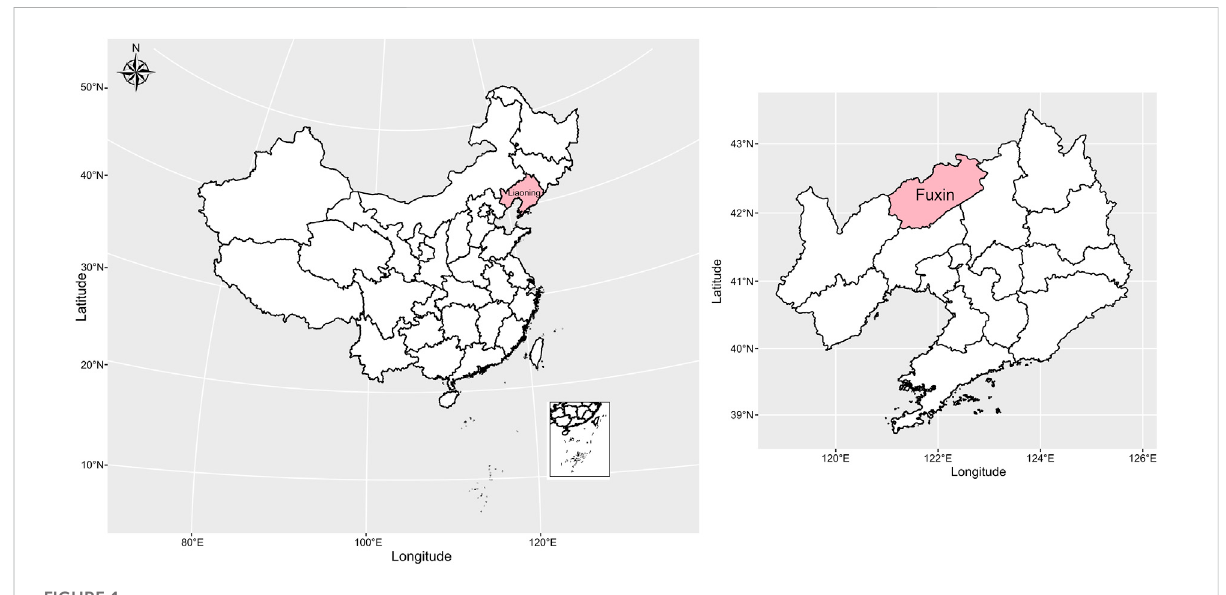
FIGURE 1 Geographical positions of the sampling population in this